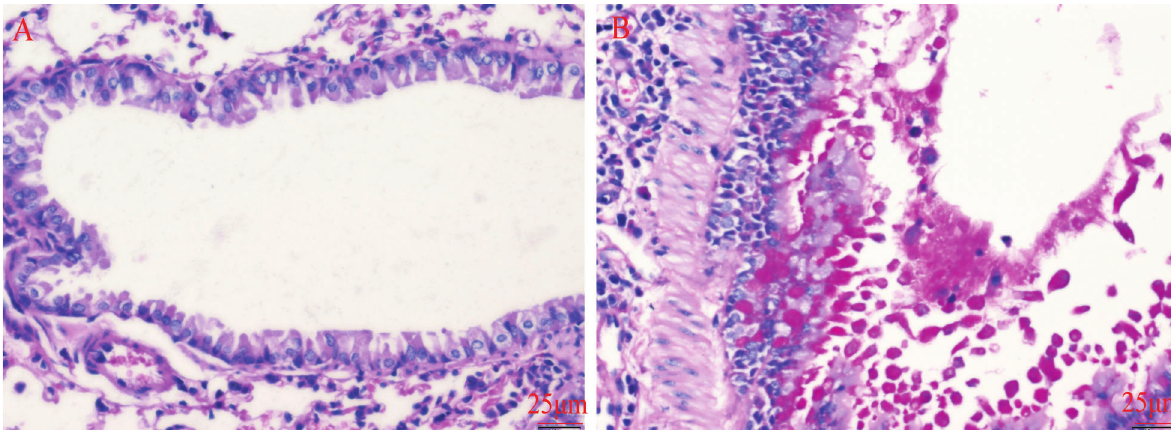
Figure 4. Alcian blue-periodic acid Schiff staining ( (cid:3) 400; bar, 25 m m) showing the normal control group with rare goblet cell and no mucus secretion ( A ) and the asthmatic model group ( B ) with increased goblet cell hyperplasia in airway epithelia and mucus secretion.